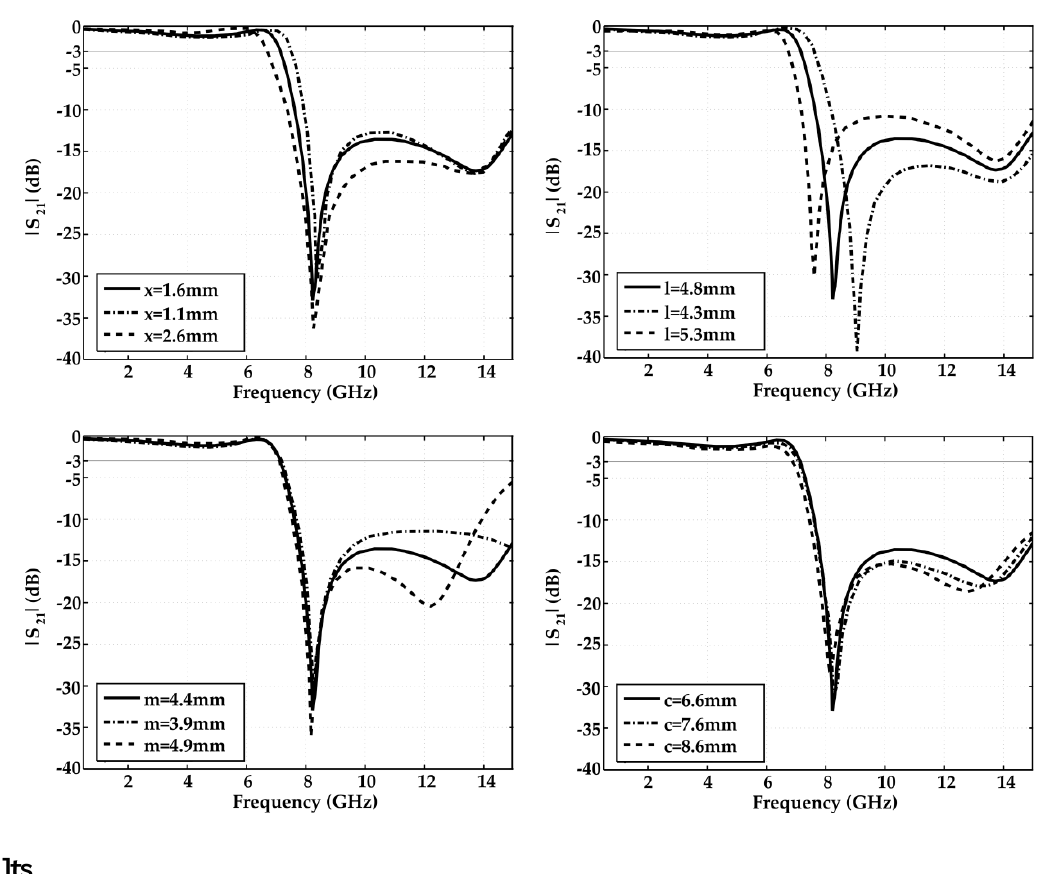
Figure 6. Parametric analysis of the